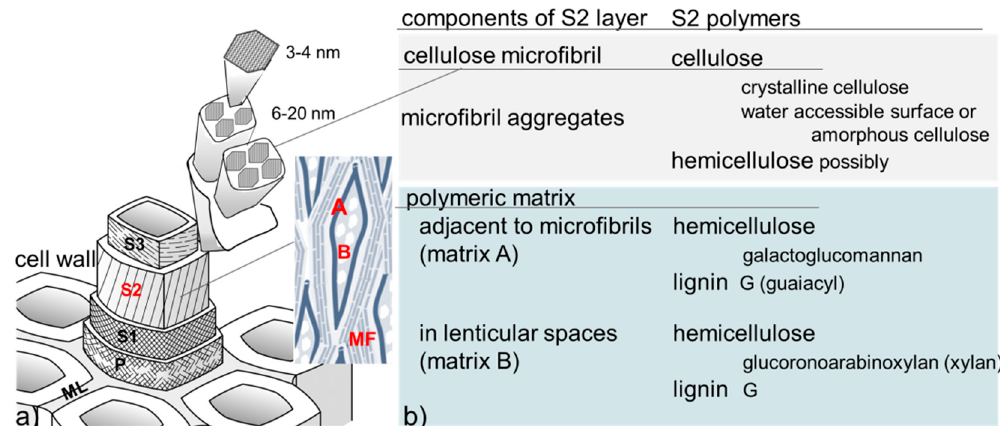
Figure 1. ( a ) Schematic representations of the structure of wood cell walls (P: primary layer, S: secondary layer, ML: middle lamella (based on Reference [7]), MF: microfibril, A: matrix close to fibrils, B: lenticular matrix); ( b ) components of S2 cell wall layer, e.g., for a softwood like spruce.